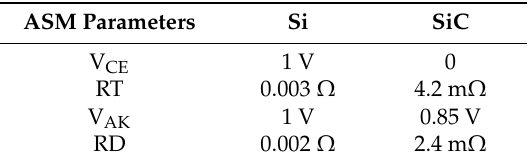
Table 5. Parameters to evaluate conduction losses.